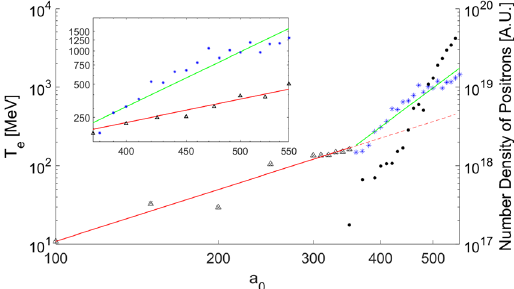
Figure 4. Plot of extracted fast electron energy against incident laser a 0 . Black triangles indicate EPOCH simulations for which no positrons were measured while the black crosses indicate equivalent OSIRIS simulations, the red line is a fit to both sets of data corresponding to ∝ . ± . T a 02 18 0 18 . The blue asterisks indicate results from EPOCH simulations for which positrons were detected. The green line is a fit corresponding to ∝ . ± .